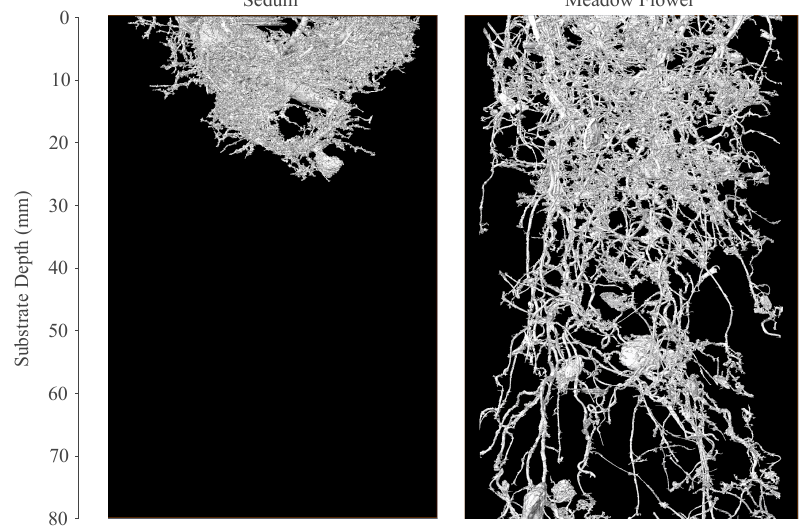
Figure 8. 3D volume of surface-connected root networks for Sedum and Meadow Flower vegetation types, identified from XMT data. T8.